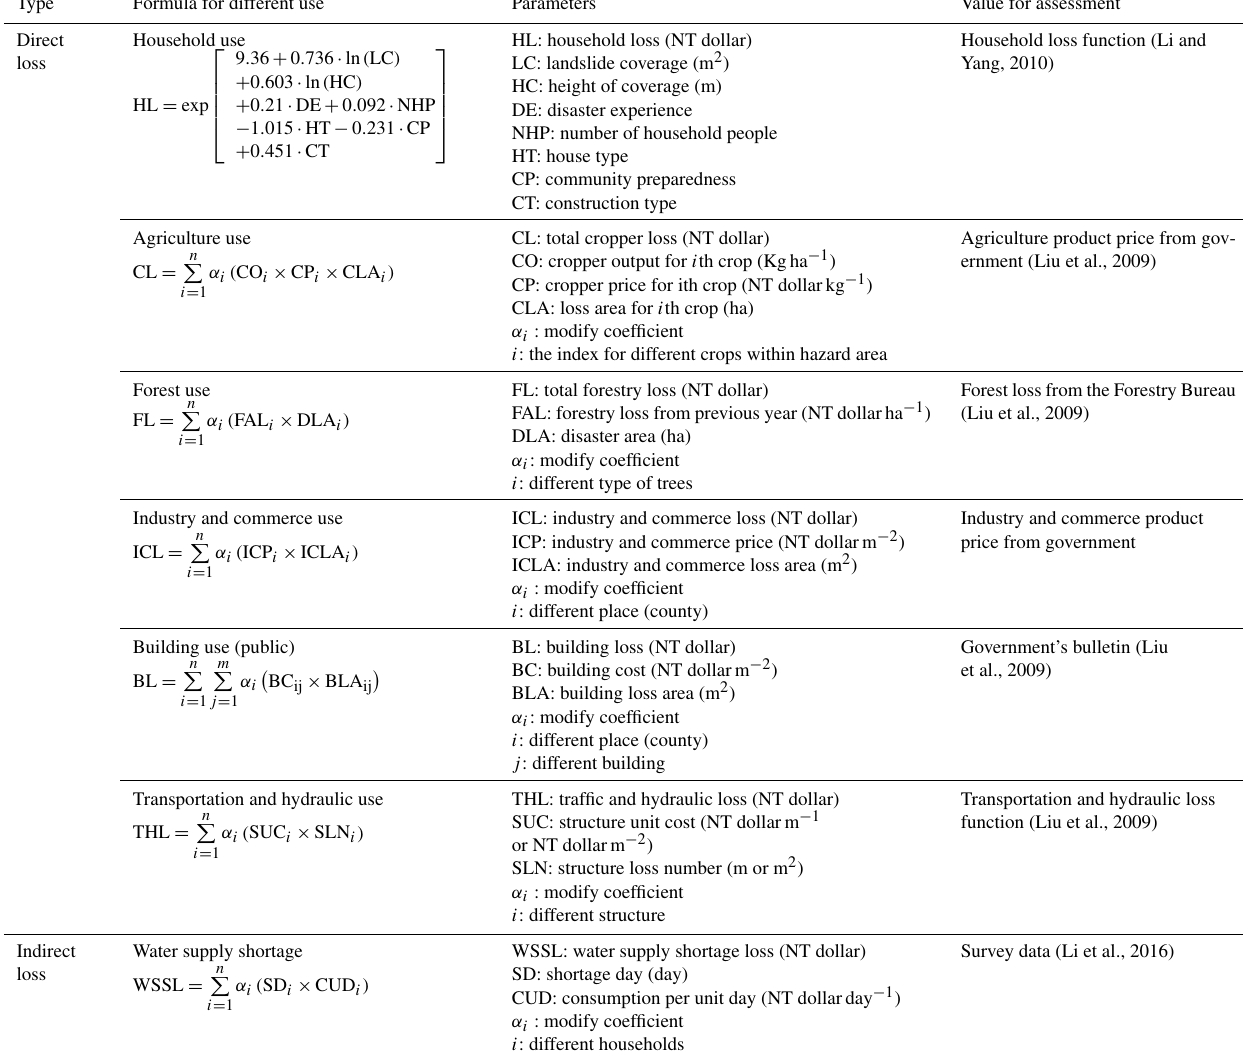
Table 1. Property loss function of slope land disasters. Type Parameters Value for